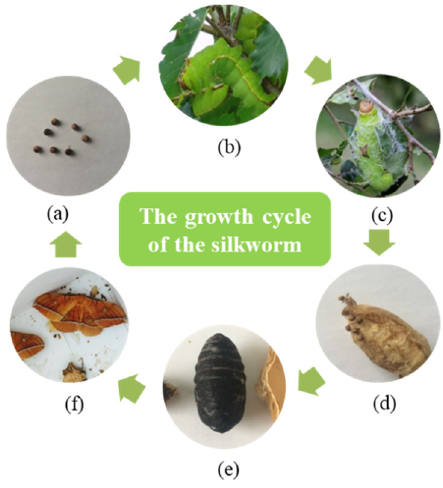
Figure 1. The growth cycle of A. pernyi : ( a ) eggs laid by an adult moth; ( b ) larva; ( c ) silkworm spinning; ( d ) cocooning; ( e ) preadult; ( f ) an adult moth.